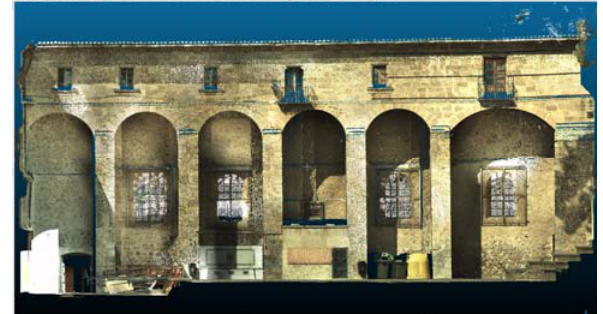
Figure 9: comparing cloud to cloud with Cloudcompare. Clouds data 2015 and 2019